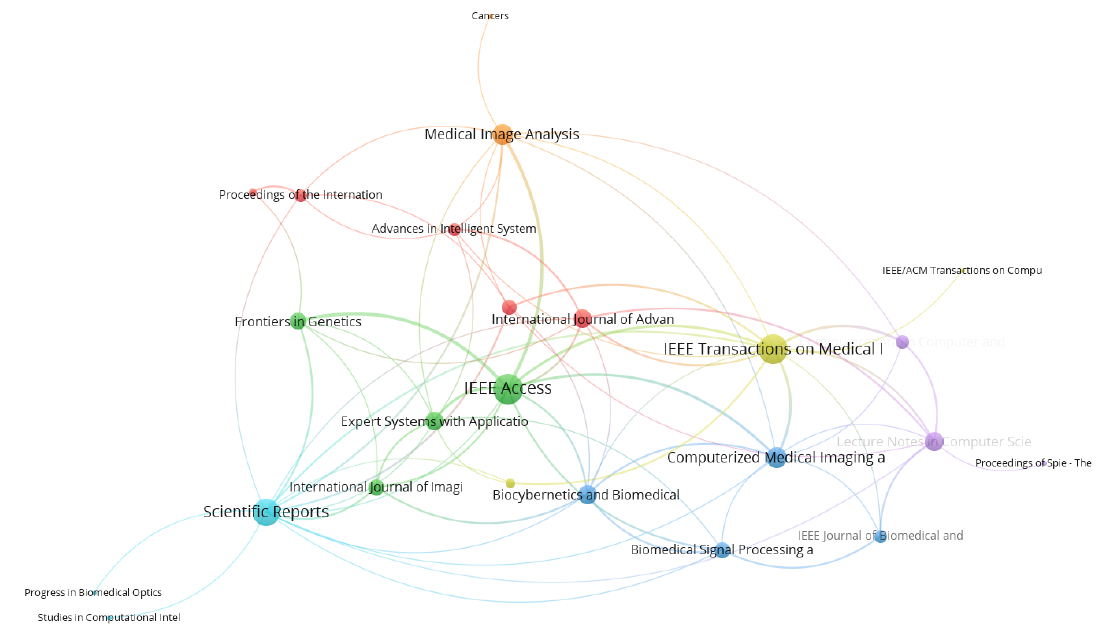
Figure 6. Citation network visualization of journals in publication for